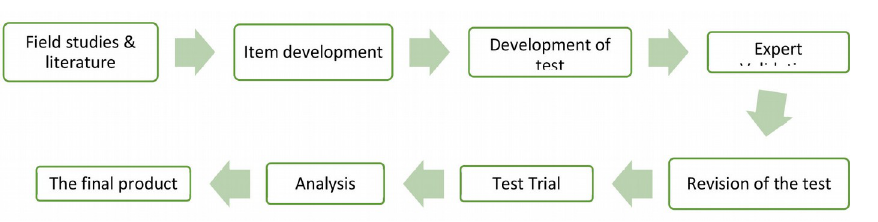
Figure 1. Research